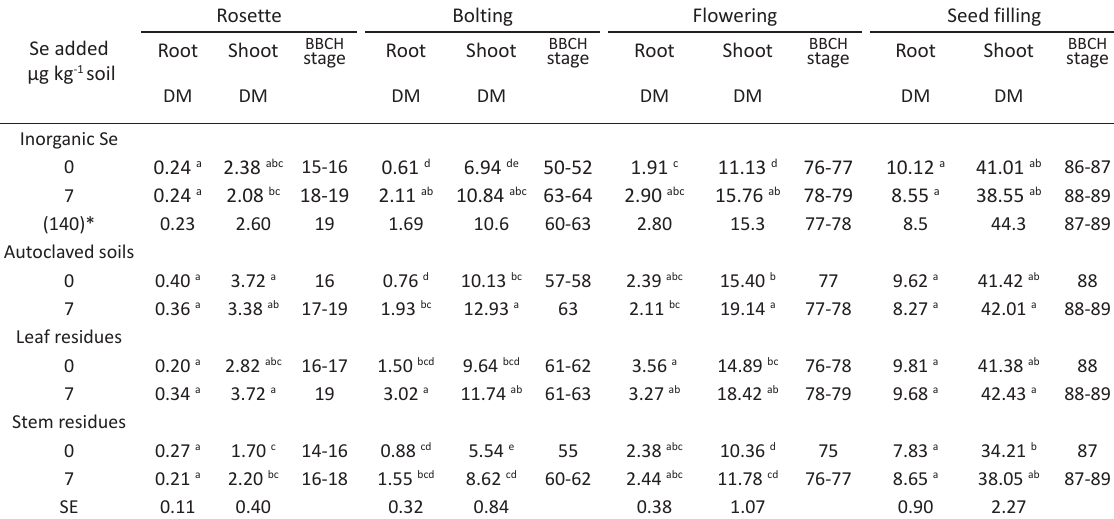
Table 1. Roots and shoots dry matter (DM, g plant -1 ) and phenological development expressed on the BBCH-scale at different growth stages of B. napus L. plants grown in soil treated with inorganic Se (0, 7 and 140 µg kg -1 soil), organic Se (leaf and stem residues, 0 and 7 µg kg -1 soil) and in autoclaved soil with inorganic Se (0 and 7 µg kg -1 soil) Se added µg kg -1